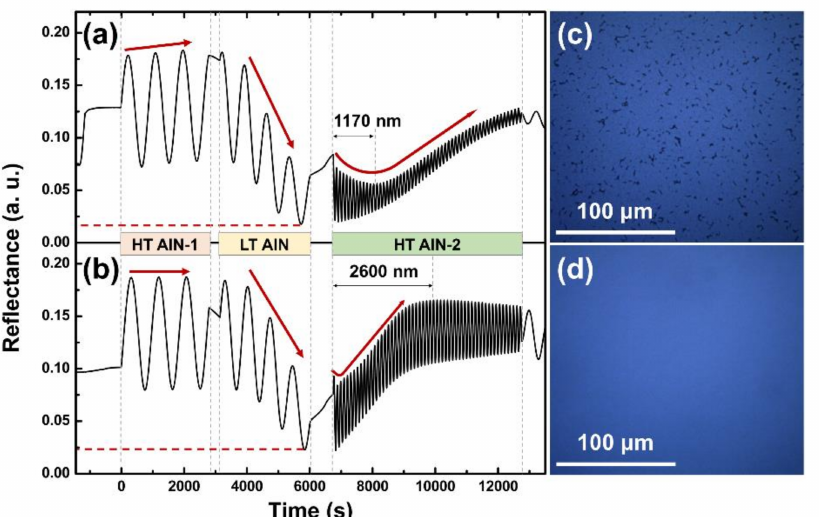
Figure 9. Reflectance (405 nm) transients for MSG-AlN grown on ( a ) MOCVD AlN buffer and ( b ) sputtered AlN buffer. Final optical microscope images for MSG-AlN grown on ( c ) MOCVD AlN buffer and ( d ) sputtered AlN buffer. Reprinted with permission from [17]. Copyright {2018} American Chemical